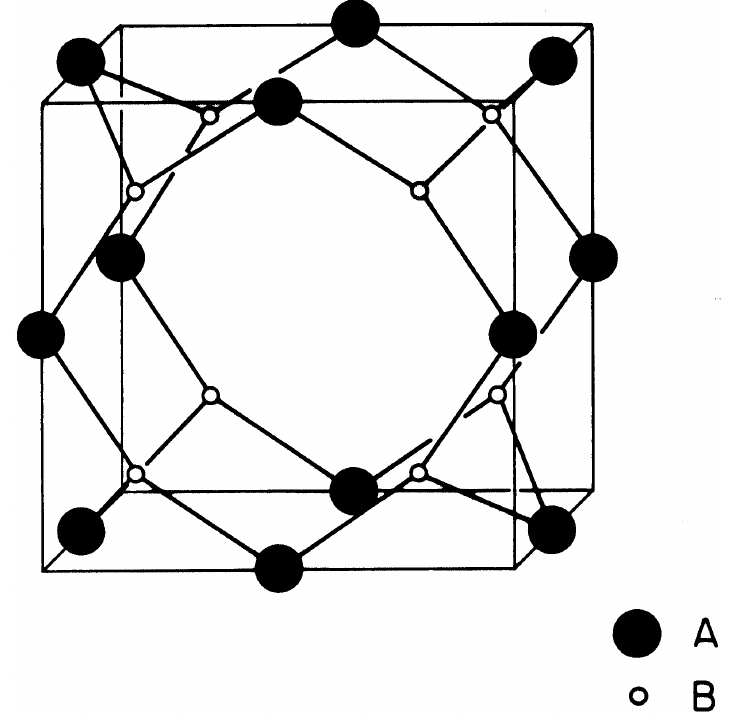
Fig. 1 Drawing of Moravia structure-type, in space group